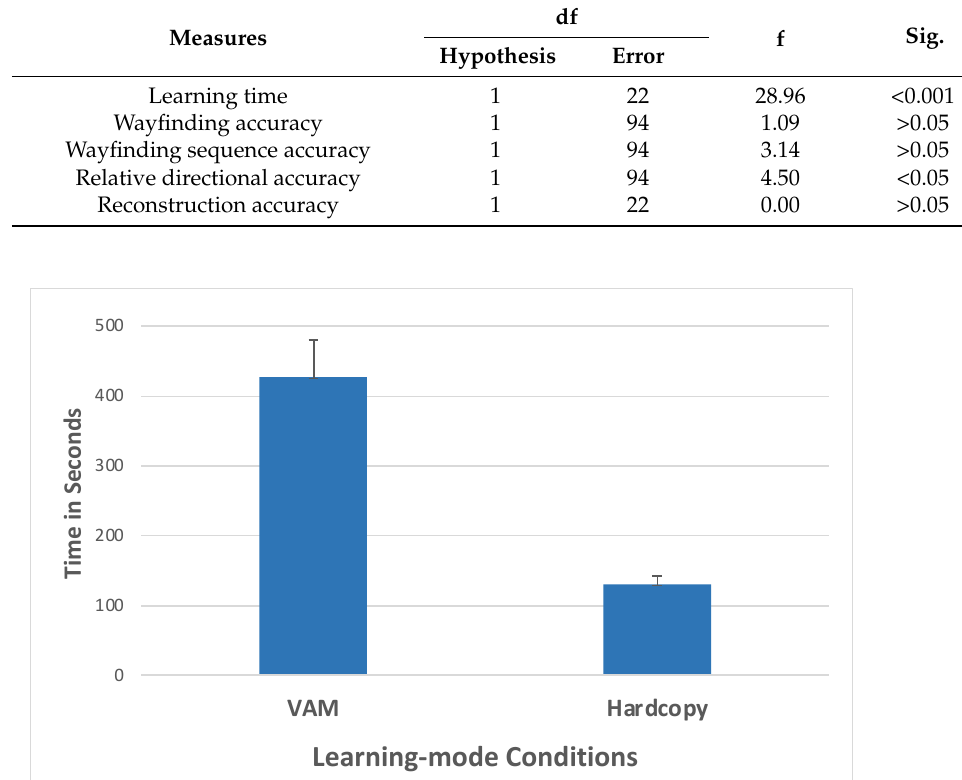
Figure 6. Mean learning time as a function of learning-mode conditions.